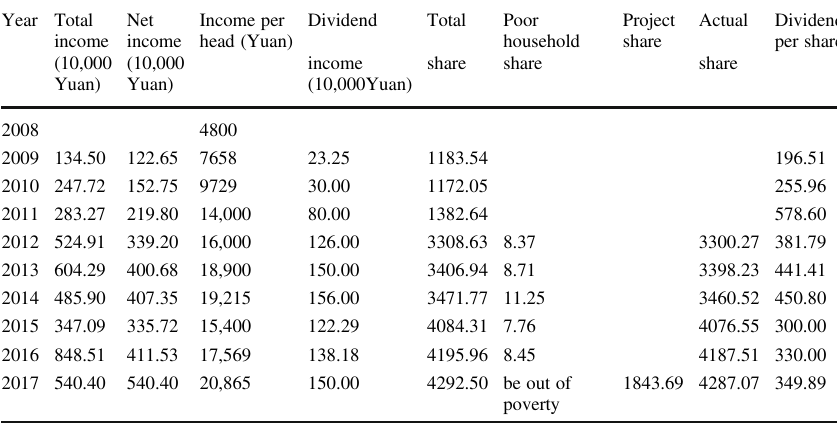
Table 1 Meilong Cooperative Income Distributions Data (2008 –